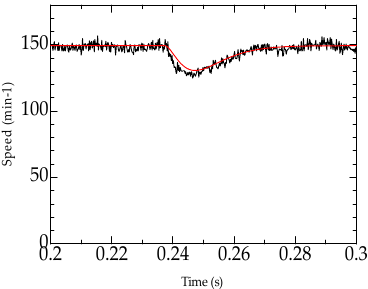
Figure 16. Disturbance response of the tuned PI ‐ P gain controller.